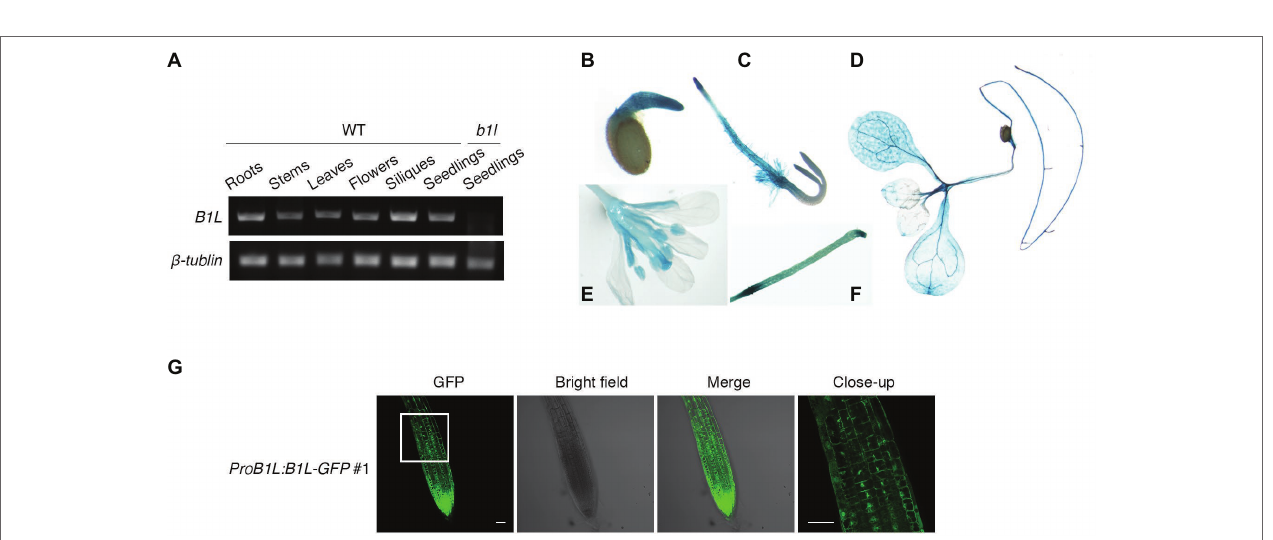
FIGURE 3 | The expression of B1L in different tissues and the subcellular localization of B1L. (A) RT-PCR analysis of B1L transcripts in the different tissues of wild type. The B1L transcript in the b1l mutant seedlings was used as a negative control. β -TUBULIN was used as a loading control. (B–F) Histochemical analysis of the GUS reporter gene expression driven by the B1L promoter. The GUS signal was detected in 1-day-old seedlings (B) , 2-day-old-seedlings (C) , 10-day-old seedlings (D) , and 8-week-old mature plants (E,F) . (G) Localization of B1L in transgenic plants expressing B1L-GFP driven by its native promoter ( ProB1L:B1L-GFP #1). The signals in the root tips of 5-day-old plants were visualized. Bar = 50